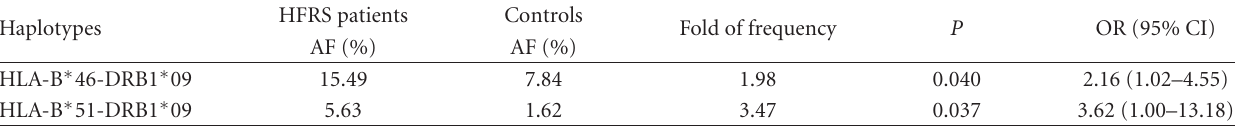
Table 4: Comparison of the haplotype frequencies in hemorrhagic fever with renal syndrome population and control group. HFRS patients Controls Haplotypes Fold of frequency P